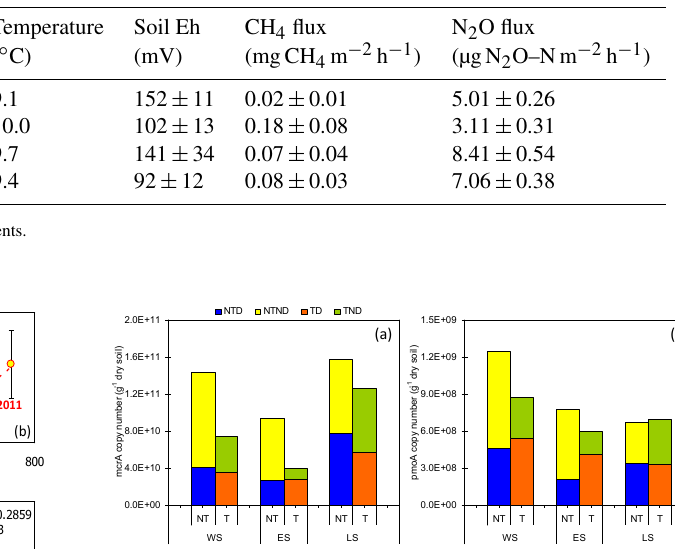
fallow and early-rice seasons (Fig. 4b, P < 0.05) though dition, tillage treatments (TND and TD) significantly de- creased the abundance of methanogens during the previous winter (Fig. 4b, P < 0.001) and following early-rice seasons (Fig. 4b, P < 0.01) in comparison to non-tillage treatments (NTND and NTD), except in the late-rice